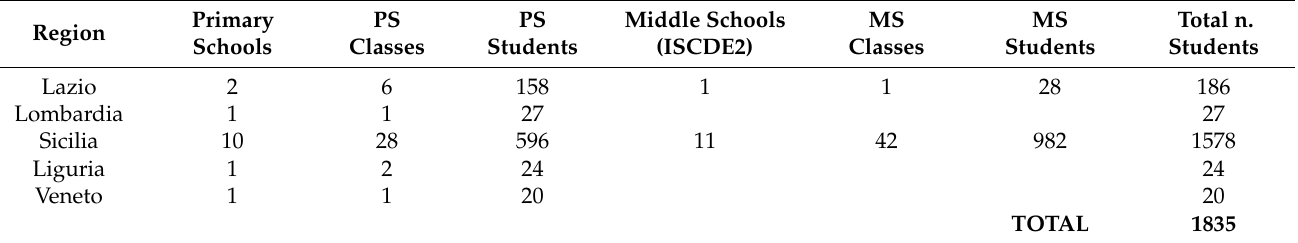
Table 5. Schools involved in the Salvina and the environment educational online gaming experience.